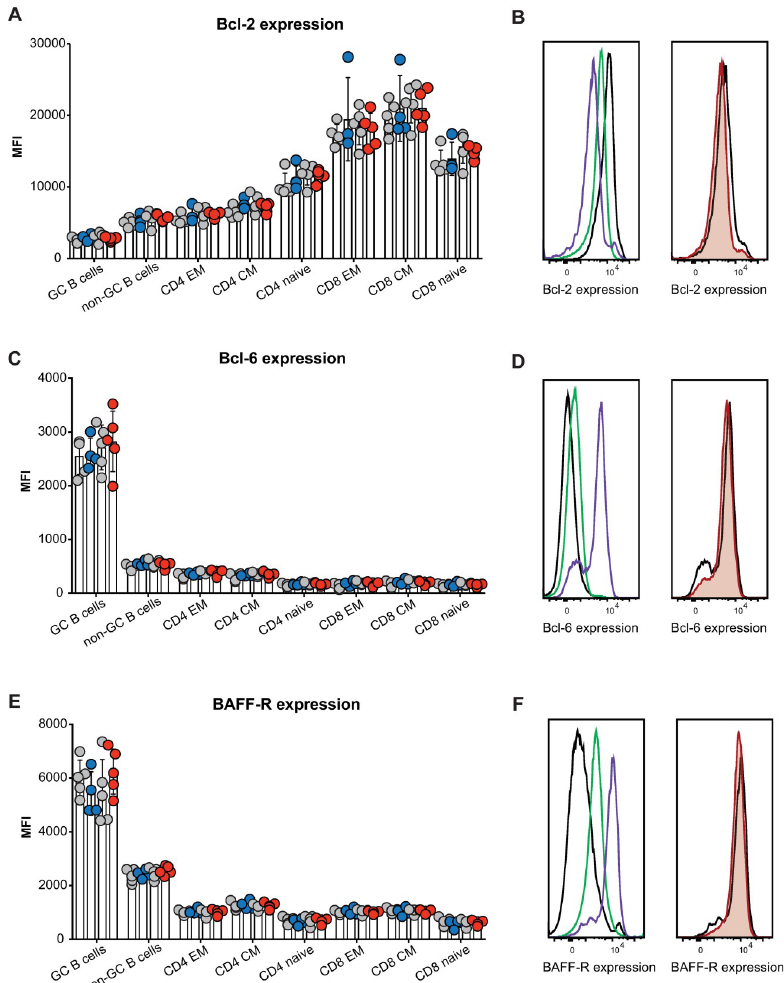
Fig 4. Fbxo10 frameshift or missense mutation do not discernably alter the protein expression levels of putative Fbxo10 targets in lymphoma. (A,C,E) Mean fluorescence intensity (MFI) for BCL2, BCL6 or BAFF-R expression, respectively, in splenic B and T cell subsets of Fbxo10 +/+ , Fbxo10 fs/fs , Fbxo10 E54K/E54K mice 10–20 weeks old, day 7 post- immunisation with SRBCs. (B,D,F) Left panel: representative histogram overlay of fluorescent antibody staining for intracellular BCL-2 or BCL-6 or cell surface BAFF-R in T cells (black), non-GC B cells (green) or GC B cells (purple). Right panel: representative histogram overlay for BCL2, BCL6 or BAFF-R expression in Fbxo10 +/+ (black) versus Fbxo10 E54K/E54K (red) GC B cells. Each dot represents an individual animal, with genotypes as in Fig 2. Data are representative of n = 2 experiments on mice 10–20 weeks old, 7 days post-immunisation with SRBC, and similar results obtained for n = 2 experiments on un-immunised mice 40–50 weeks old. Statistical analysis: t-test corrected for multiple comparisons using the Holm-Sidak method yielded no evidence for significant differences between mutants and wildtype controls with p <